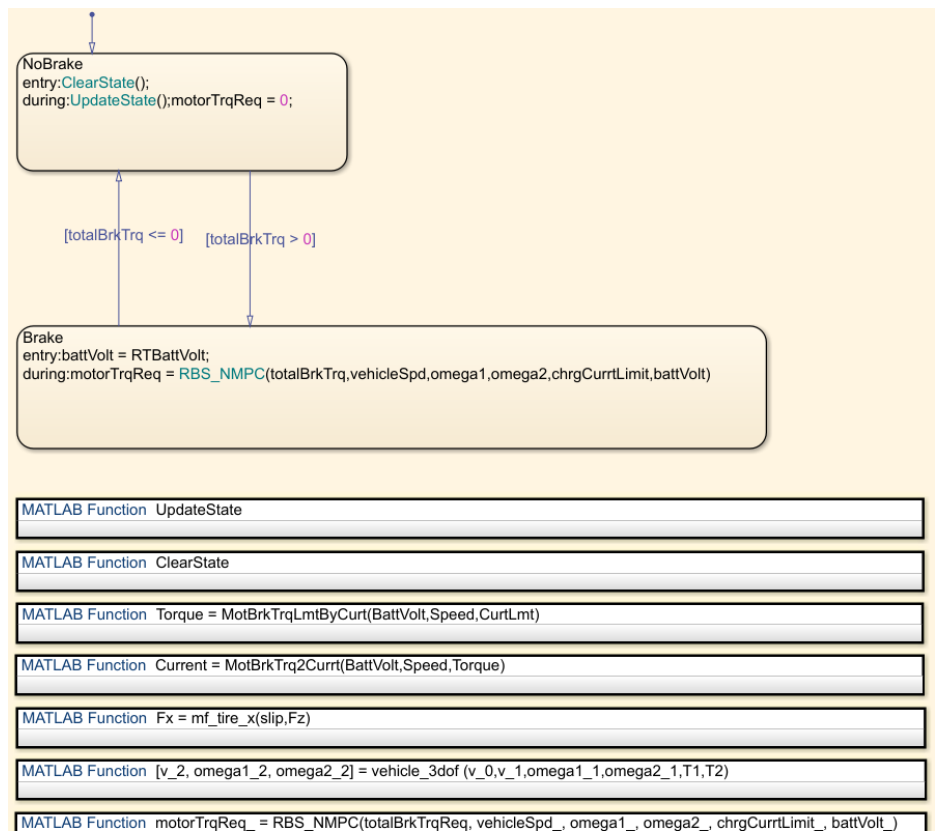
Figure 5. The Simulink model for the NMPC algorithm.